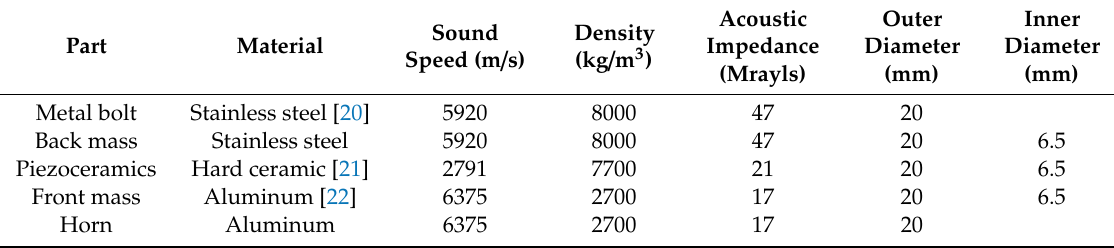
Table 1. Material properties by transducer